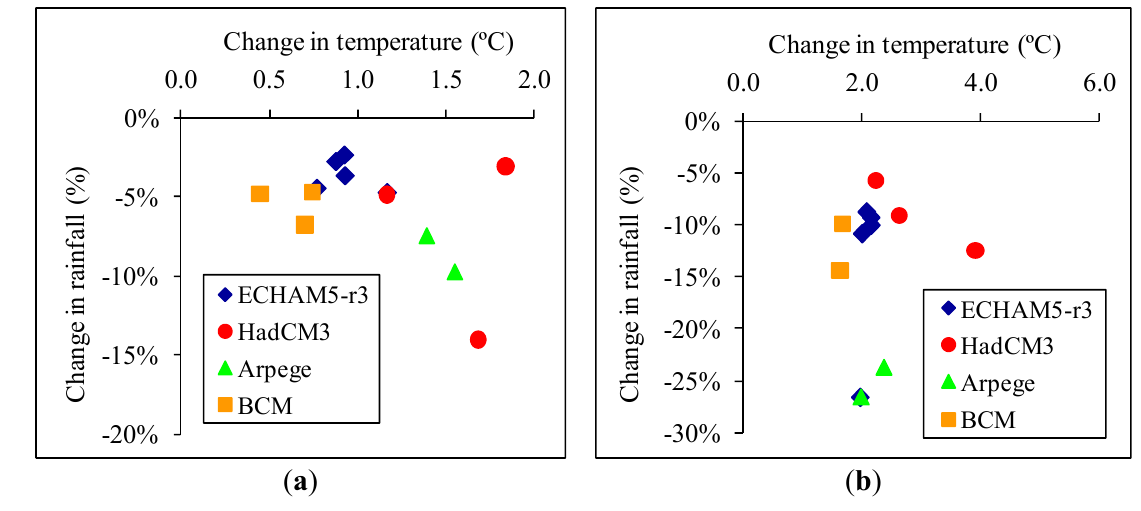
Figure 3. Climate change scenarios for annual mean temperature and rainfall for: ( a ) 2031–2060 and ( b ) 2069–2098 (ENSEMBLES project).